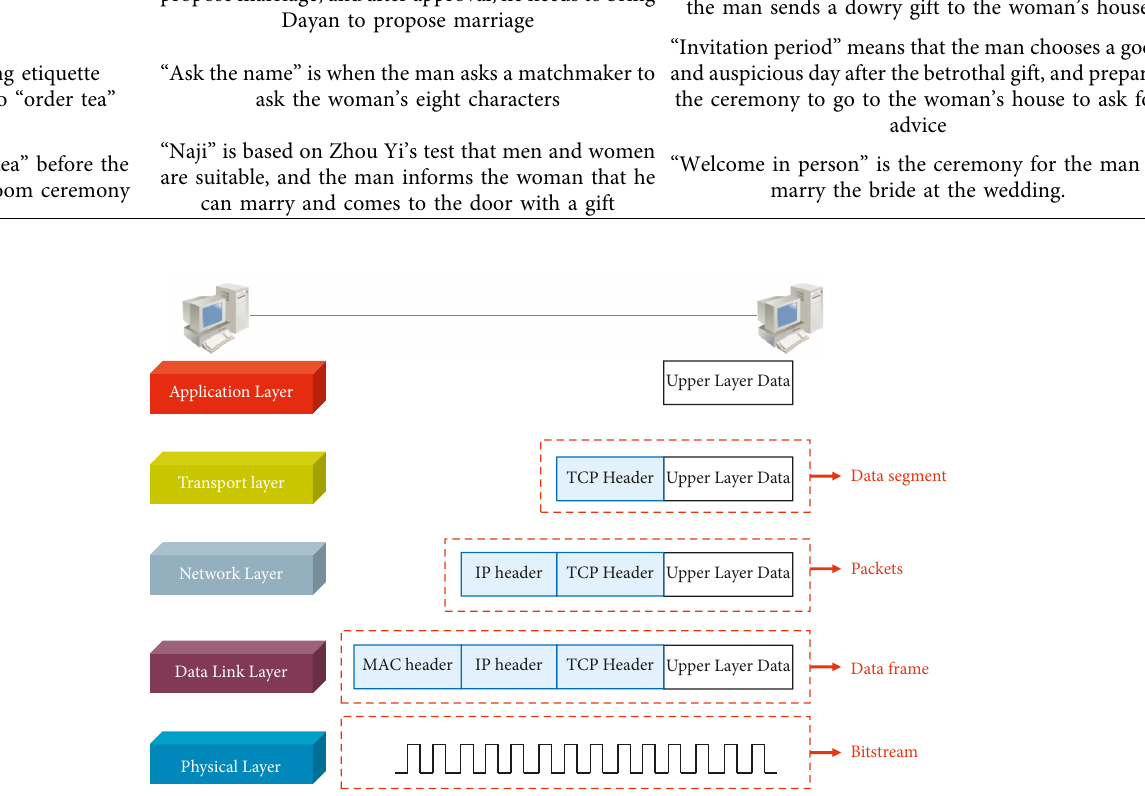
Figure 1: Computer network communication